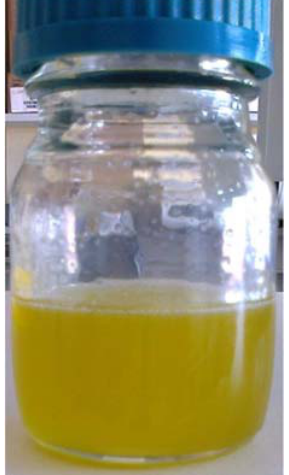
Figure 4. The enriched olive oil with OMW polyphenols. Table 1. Radical ‐ scavenging effect (IC 50 ) of micellar dispersions.